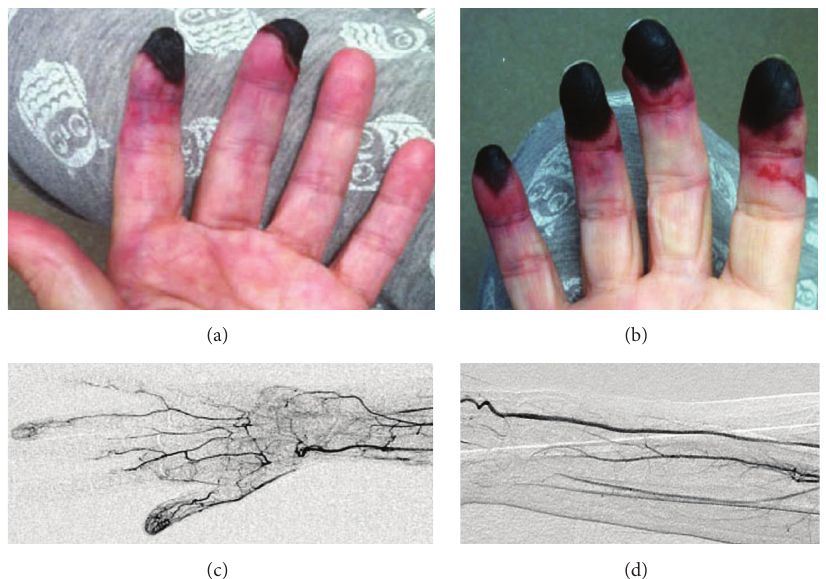
Figure 1: Digital gangrene. (a) and (b) show digital gangrene affecting 2nd and 3rd fingers, and the tips of the second to fifth digits of the left and right hands, respectively. (c) is an angiogram of the left hand showing occlusion of the radial artery at the wrist with lack of filling of the superficial and deep palmar arches. (d) is an angiogram of the right forearm showing occlusion of the ulnar artery proximal to the